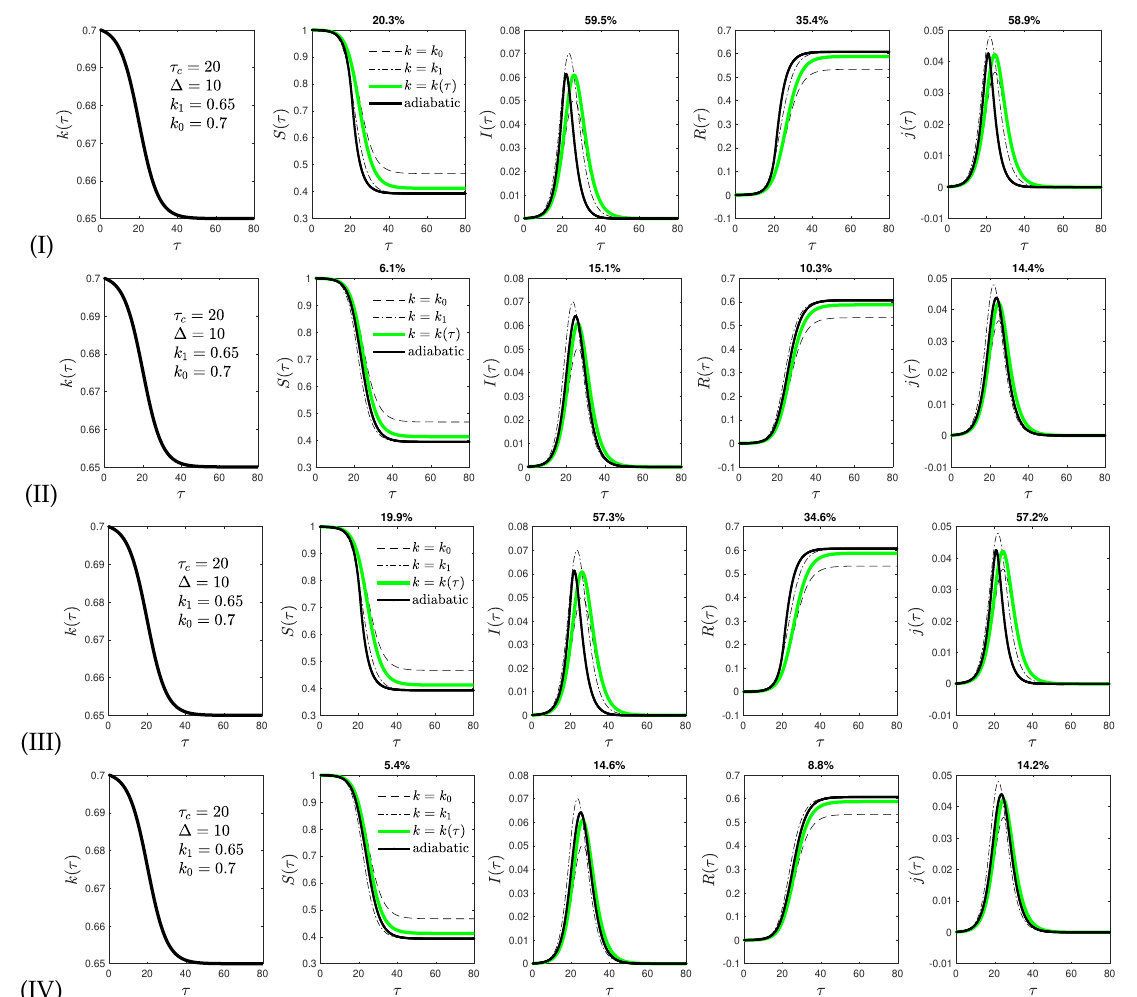
Figure 6. Same as Figure 2 but with another set of the parameters ( k 0 = 0.7, k 1 = 0.65, ∆ = 10, and τ c = 20) of the ratio k ( τ ) (6). Here, a decreasing ratio with reduced time is chosen in contrast to Figures 2–5, 7 and 8, where increasing ratios are